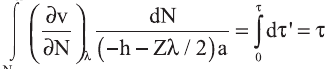
, as a function of dimen- A